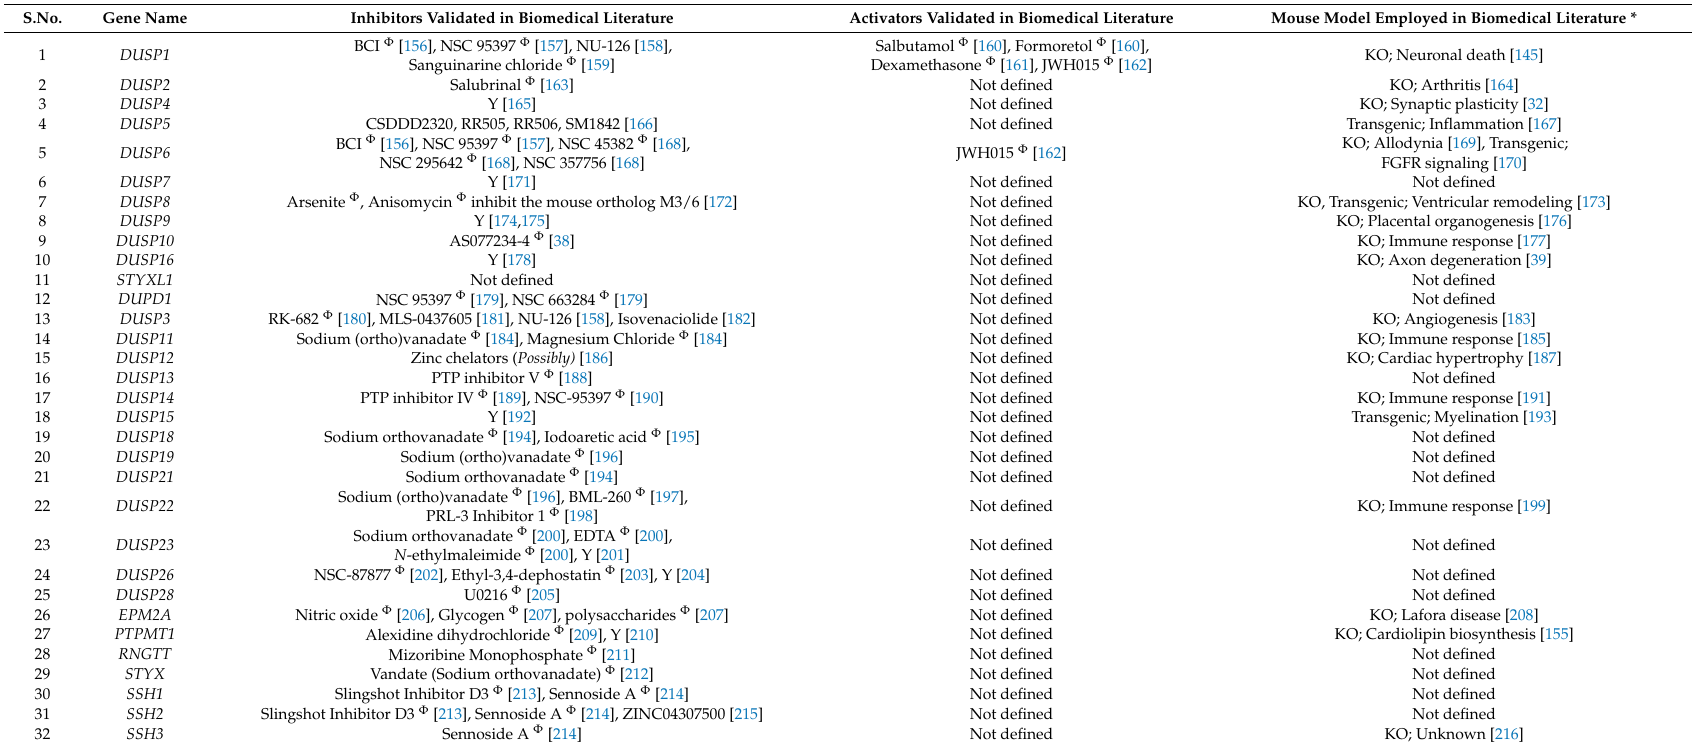
Table 2. Modulation of Dual-Specificity Phosphatase by various